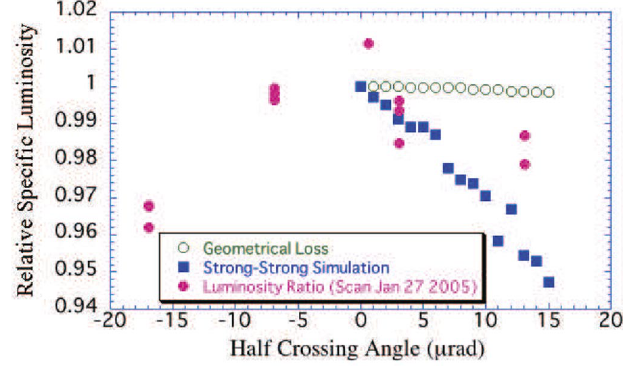
FIG. 6. (Color) Luminosity degradation due to the vertical cross- ing angle. Both an experimental result and a strong-strong simulation are shown. Also shown is a calculation of a geomet- rical